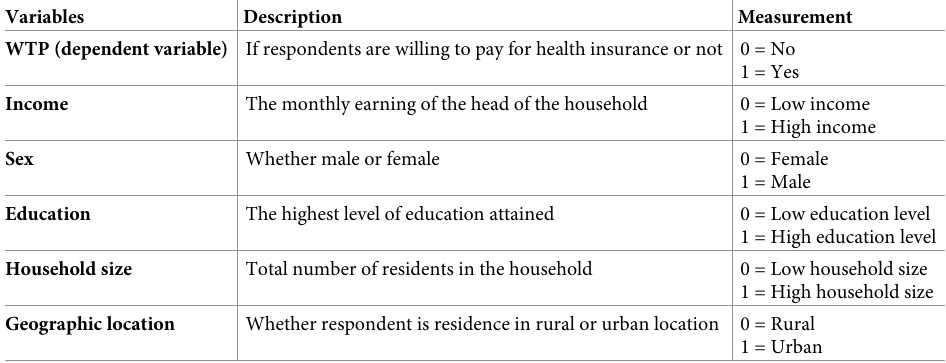
Table 2. Description of the dependent and independent variable hypothesised to explain willingness to pay.